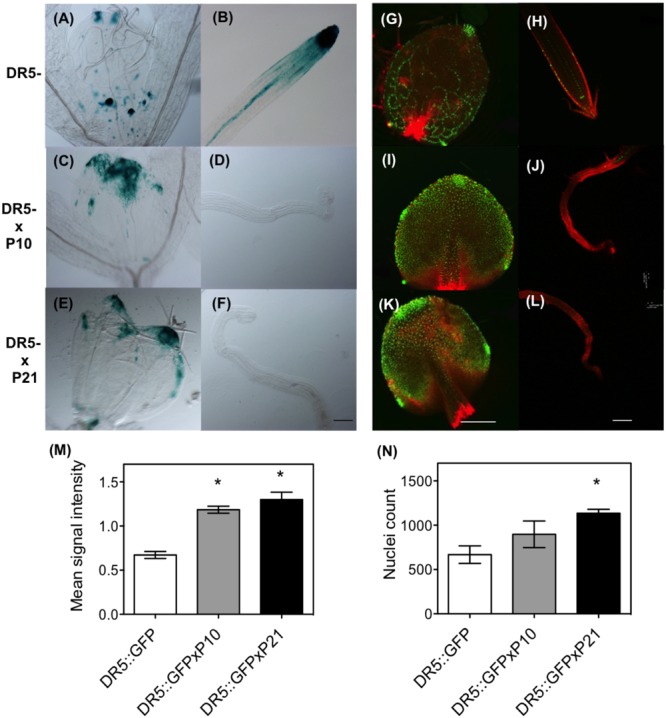
Effect of PID overexpression on auxin signaling in Arabidopsis. GUS assay with DR5::GUS (A,B); DR5::GUS in PIDOE P10 (C,D) and P21 background (E,F) at 9 DAS in the leaves and roots. Confocal images with DR5rev::GFP signal in control (G,H) and DR5rev::GFP × PIDOE P10 (I,J) and DR5rev::GFP × PIDOE P21 (K,L). Measurements of intensity of GFP signal (M) and count of nuclei expressing GFP using the leaves from various mutant lines (N). Asterisks indicate significant differences between the transgenic lines and the wild type. Error bars represent ± SE (t-test, P < 0.05). Scale bar 100 μm for GUS assay and 50 μm for confocal images.